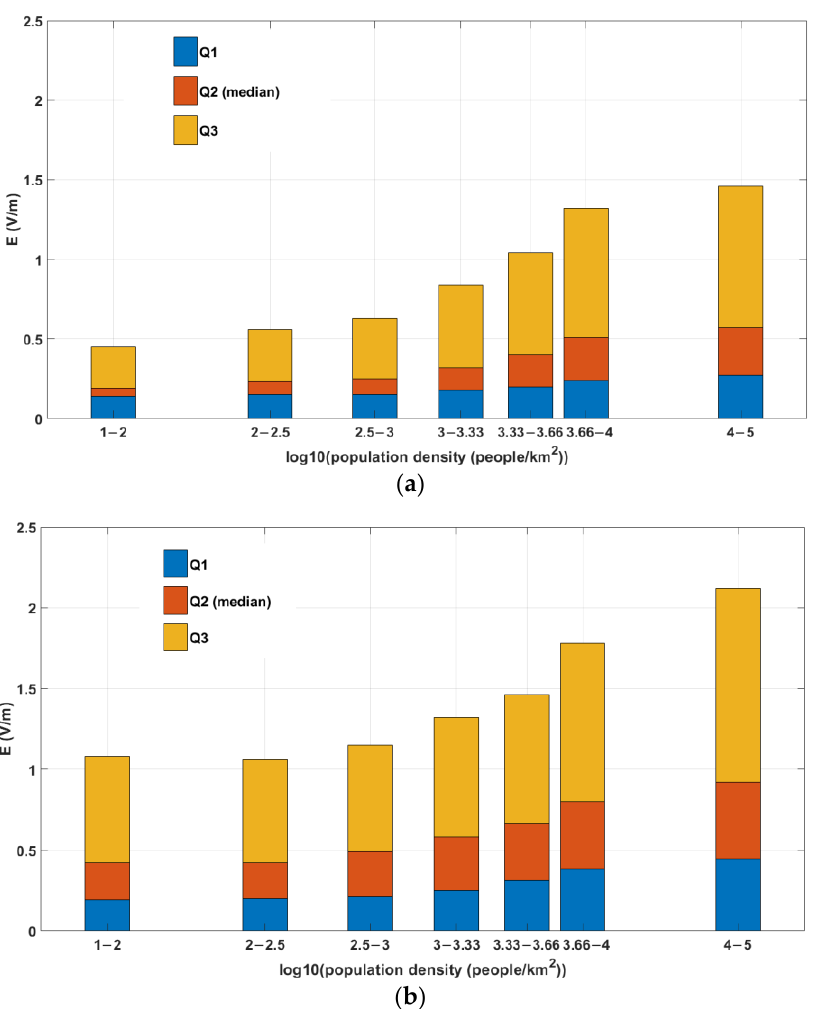
Figure 7. Median value, 25th, and 75th percentiles of E (V/m) values measured in France vs. log 10 (population density): ( a ) indoors; ( b ) outdoors.